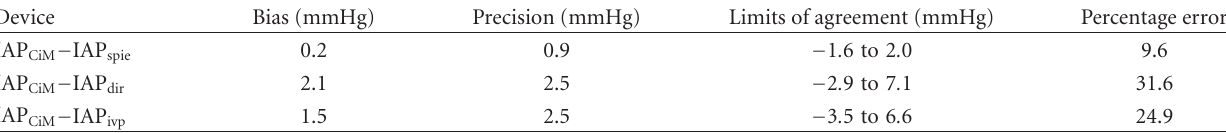
Table 1: Statistics of comparison between di ff erent device readings in the supine